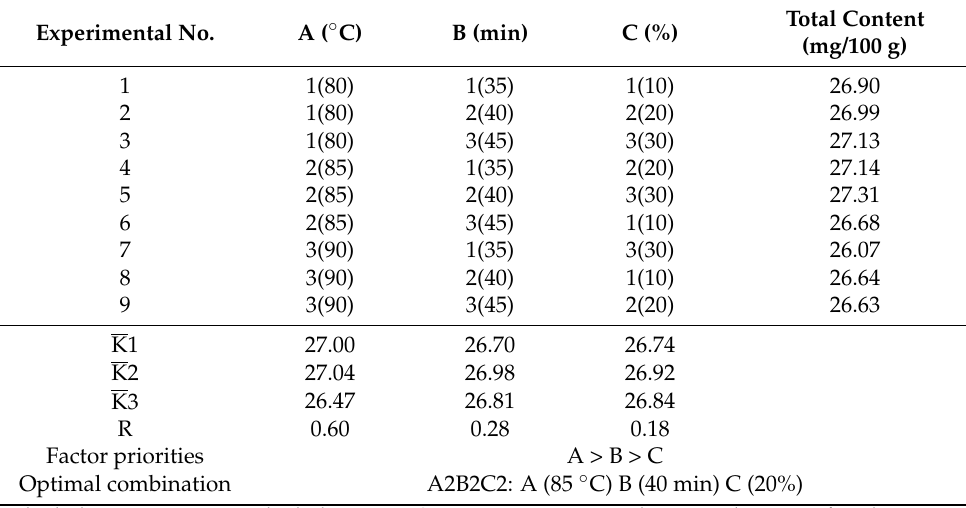
Table 2. Results of the chicken broth pretreatment orthogonal test ( n = 3).